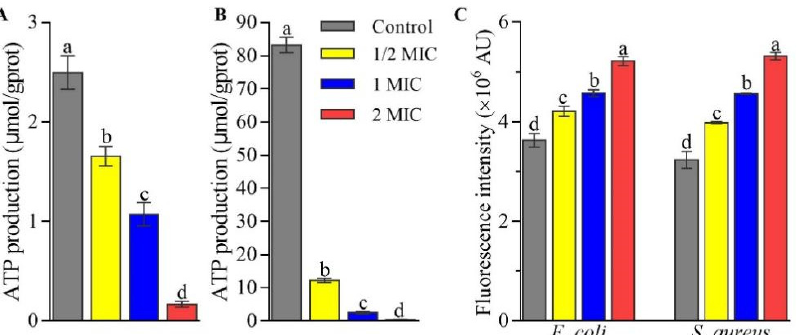
Figure 2. Effects of CFS from L. rhamnosus SCB0119 on the production of ATP ( A , B ) and ROS ( C ) in E. coli ATCC25922 ( A , C ) and S. aureus ATCC6538 ( B , C ). ROS production was detected using DCFH-DA staining. Different lowercase letters indicate significant differences among the treatments ( p < 0.05). Error bars: SD of the mean from three repeated assays.